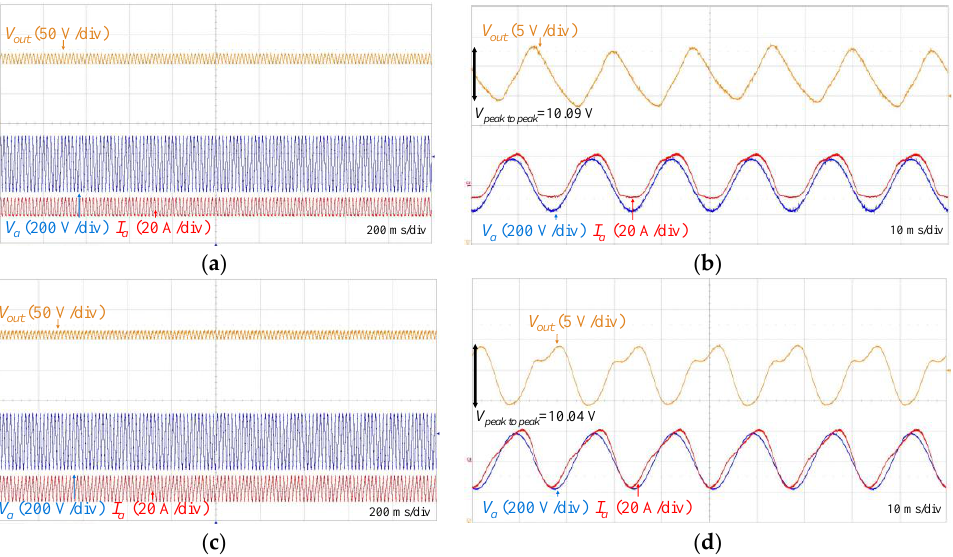
Figure 16. Output voltage regulation under fault conditions: ( a ) short-fault of single switch, ( b ) enlarged scale of Figure 16a, ( c ) short-fault of two switches in parallel, ( d ) enlarged scale of Figure 16c.